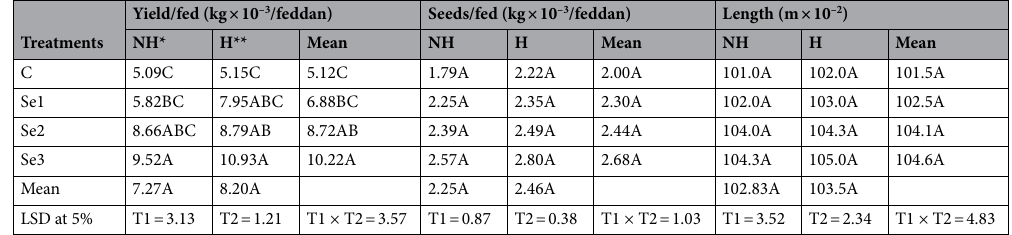
Table 5. Effect of Se and K-humate application on oat growth. *Refers to Se application without K-humate. **Refers to the simultaneous application of Se and K-humate.